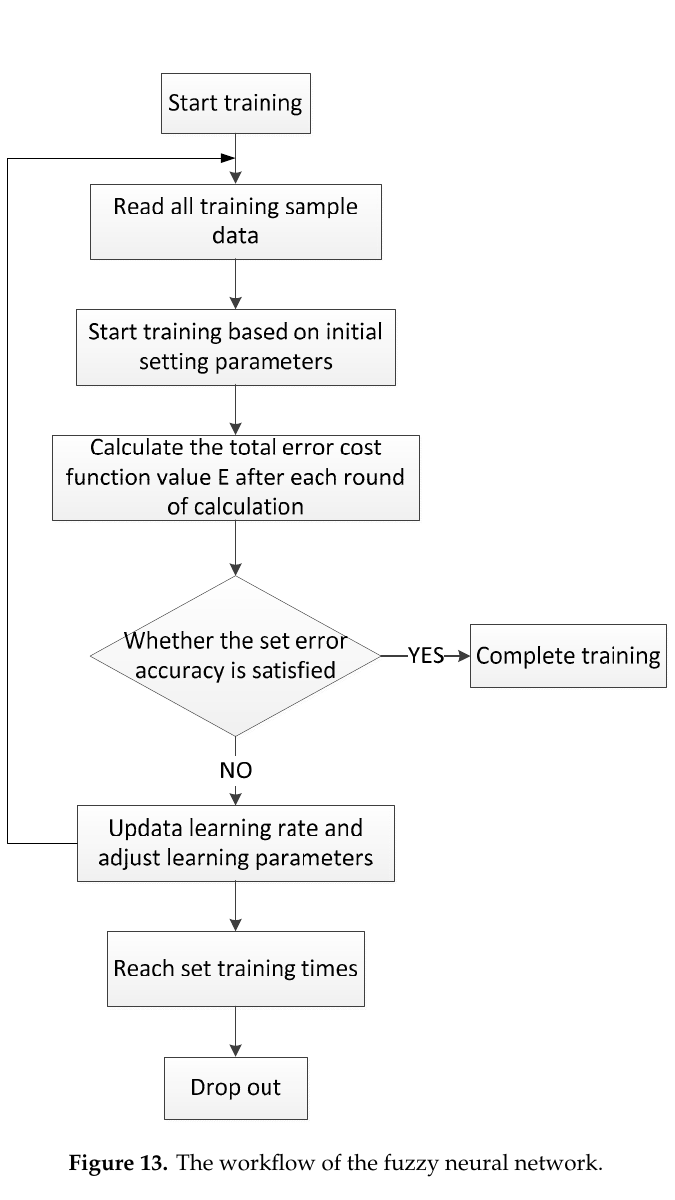
Sensors 2019 , 19 , x Figure 13. The workflow of the fuzzy neural network. Figure 13. The workflow of the fuzzy neural network.